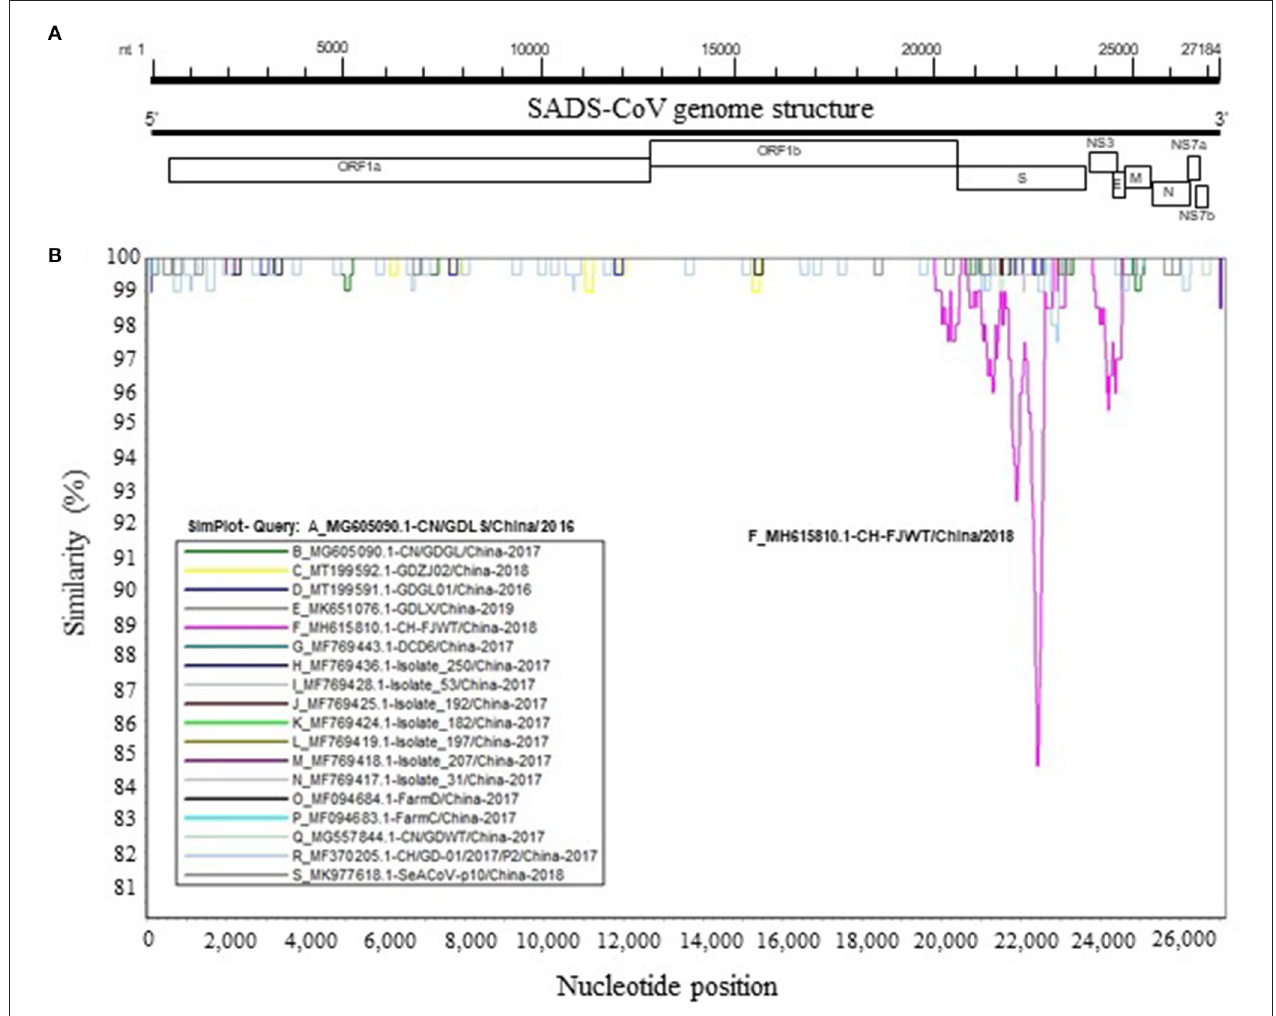
FIGURE 2 | Similarity plot of the full-length genomic sequences of non-identical SADS-CoV isolates. (A) Schematic diagram of the genomic structure of SADS-CoV. S, spike glycoprotein ORF; NS3, accessory protein NS3 ORF; E, envelope protein ORF; M, membrane protein ORF; N, nucleoprotein ORF; NS7a, accessory protein NS7a ORF; NS7b, accessory protein NS7b ORF. Numbers indicate the nucleotide position (nt) relative to the genomic sequence of SADS-CoV CH/FJWT/2018. (B) Similarity plot of viral genomes was constructed using the two-parameter (Kimura) distance model (18) with a sliding window of 200 bp and step size of 20 bp. Vertical and horizontal axes indicate the percent nucleotide similarity (%) and nucleotide position (nt) in the graph, respectively.